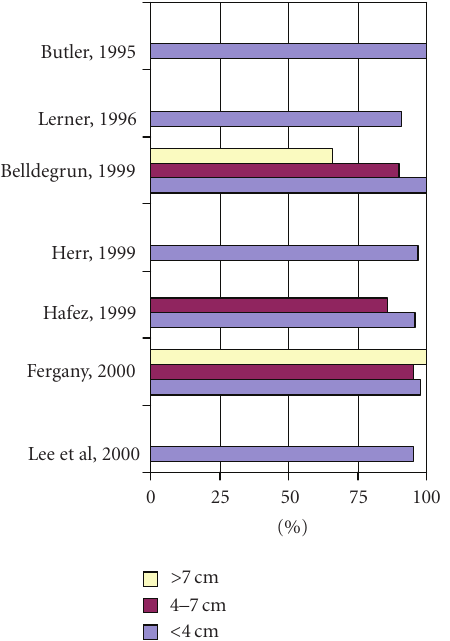
Figure 2: Five-year disease-free survival by tumor size in patients undergoing partial